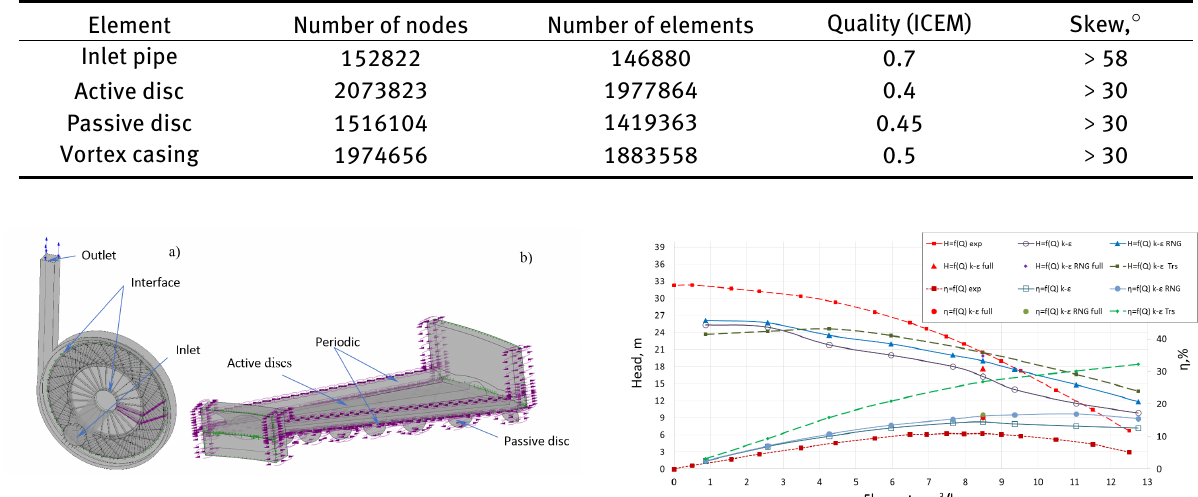
Figure 5: The calculation models of the radial labyrinth pump dedi- cated to CFD investigations: a) the entire model, b) the periodic part